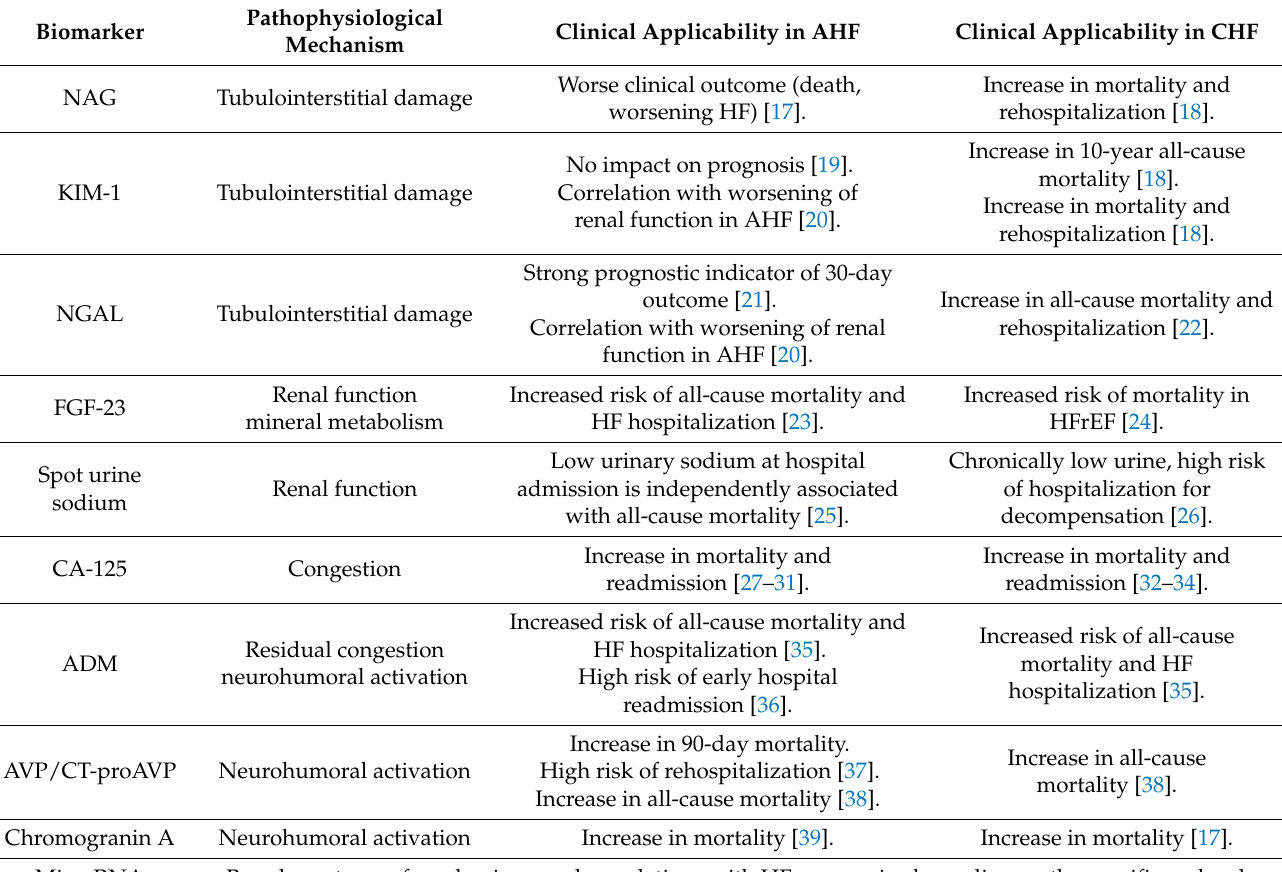
Table 2. Prognostic impact of selected biomarkers in heart failure.